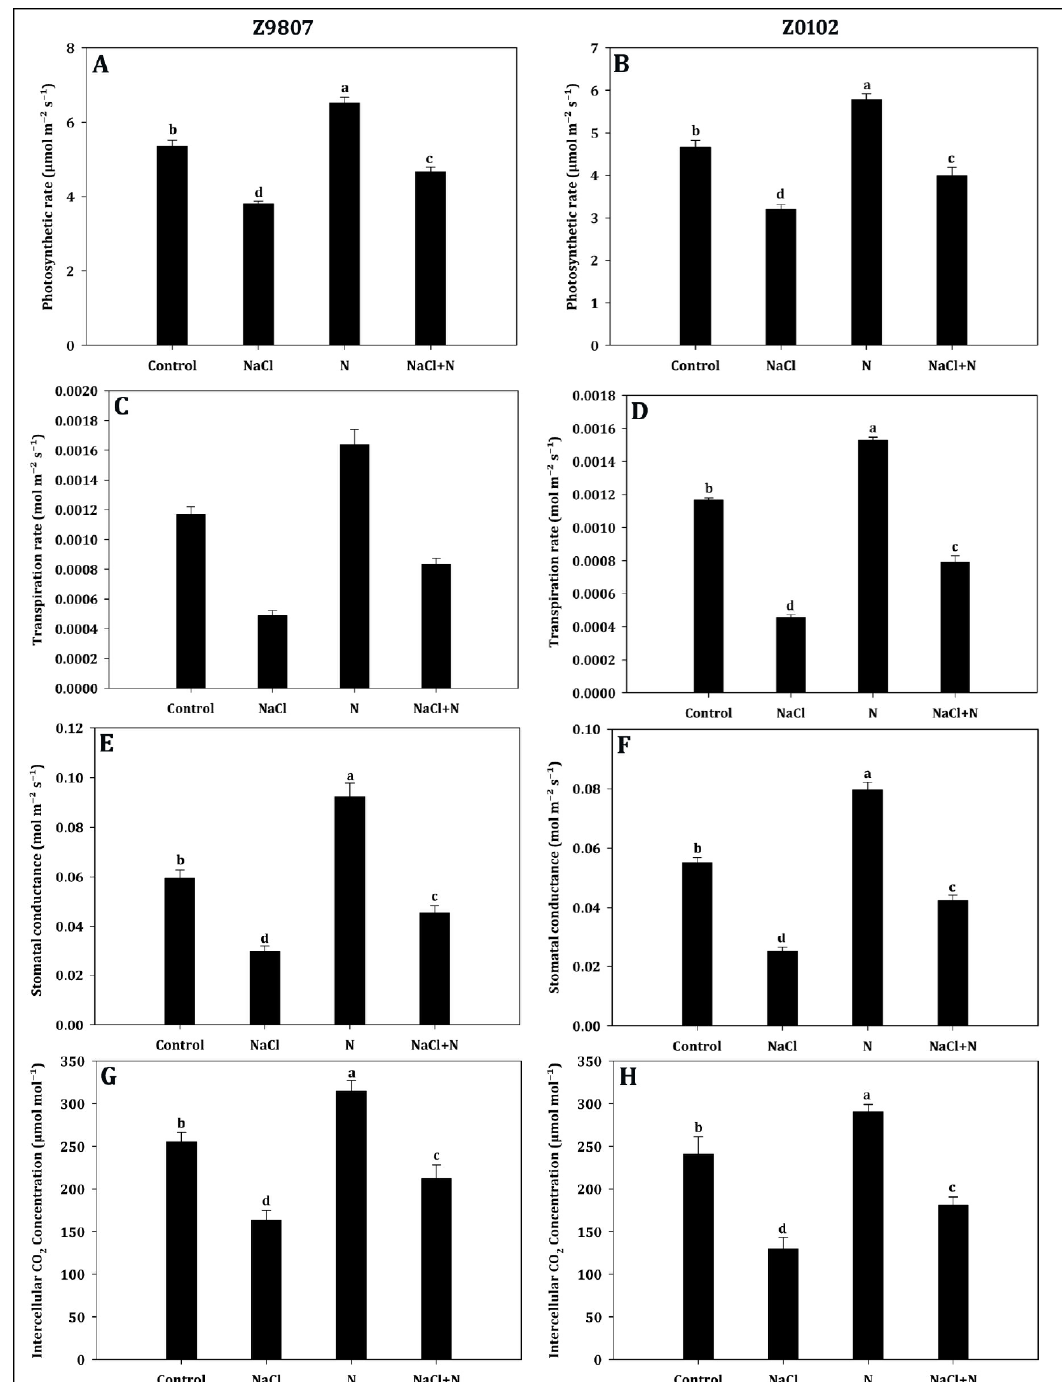
Figure 4. Effect of nitrogen supplementation on ( A , B ) photosynthetic rate, ( C , D ) transpiration rate and ( E , F ) stomatal conductance, and ( G , H ) intercellular CO 2 concentration and in Gossypium hirsutum L. under salinity stress. Data represent the mean of three replicates and bars with different letters denote significant differences at p < 0.05.